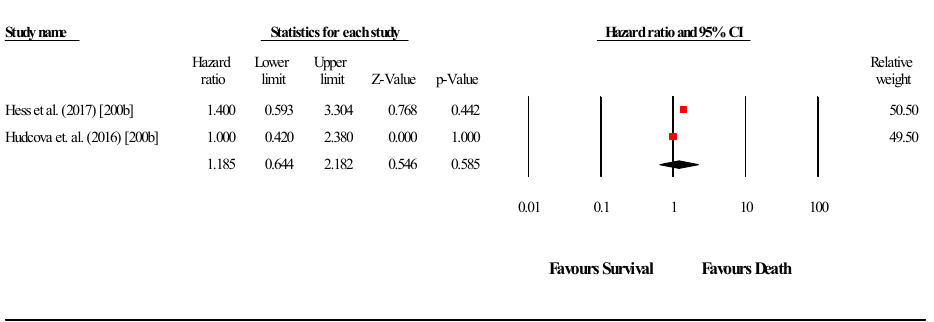
Figure 5. Forest plot for miR-200b association with OS.